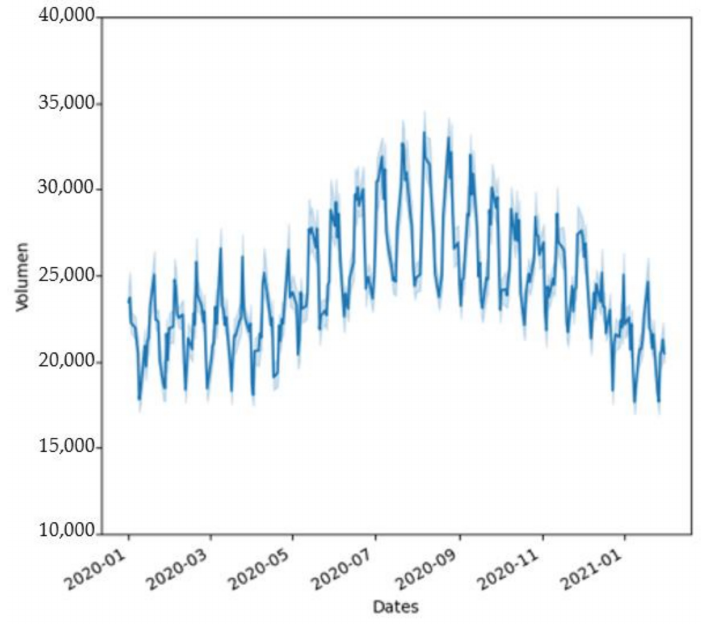
Figure 10. Shows German average traded volumes per day in Day-Ahead markets. The light blue shadow represents the 95% confidence level. Figures 9 and 10 got generated using the same code in